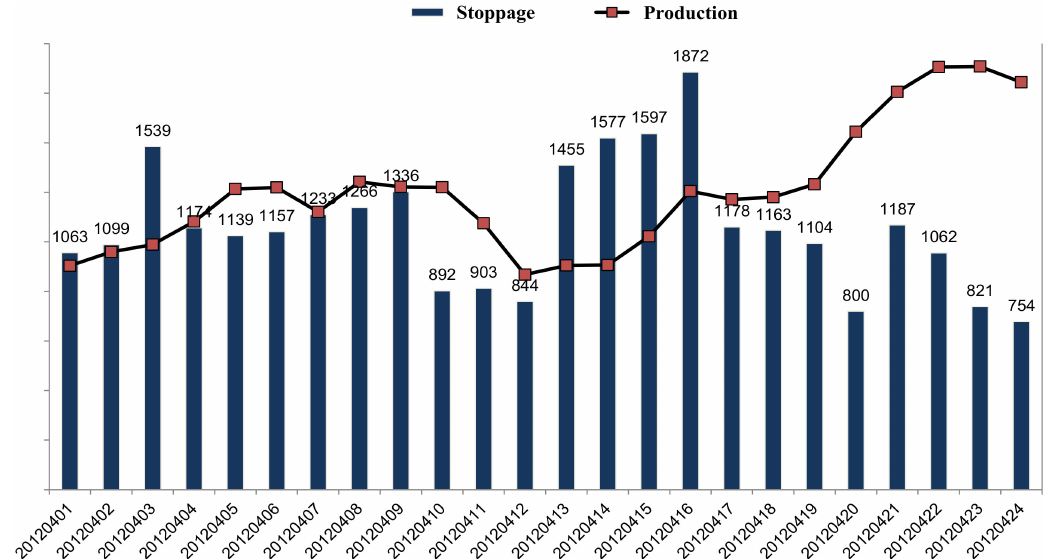
Figure 11. Improvement e ff ect of equipment faults versus the number of strips produced for the top 20% out of the die attach process equipment that caused equipment